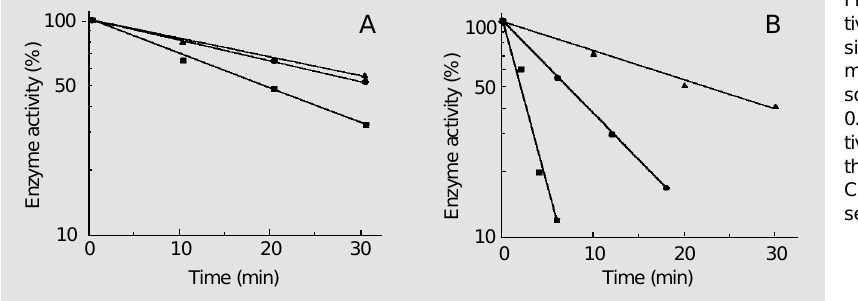
Figure 6 - Heat inactivation of purified constitu- tive alkaline phosphatase at 70 o C, pH 8.9, synthe- sized by strain 74A of N. crassa grown in high-Pi medium at 30 o C, pH 7.1. A , Triangles, circles, and squares represent the enzyme incubated in 0.03, 0.15 and 0.30 M Tris-HCl buffer, pH 8.9, respec- tively. B , Triangles, circles, and squares represent the enzyme incubated in 0.03, 0.15 and 0.30 M CHES buffer, pH 8.9, respectively. For details, see Material and